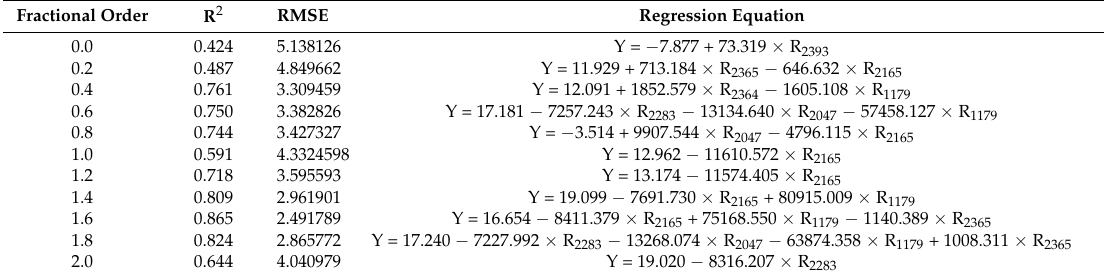
Table 2. Stepwise multiple linear regression (SMLR) model for soil-available phosphorus content. Fractional Order R 2 RMSE Regression Equation